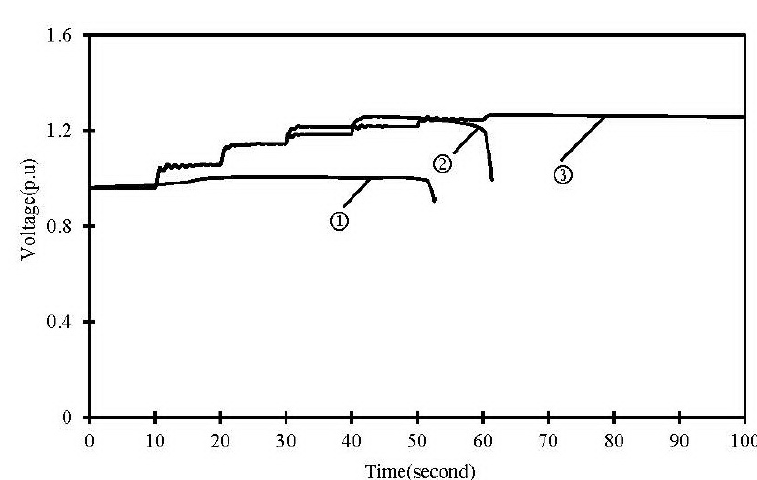
Figure 14. Voltage curve of bus